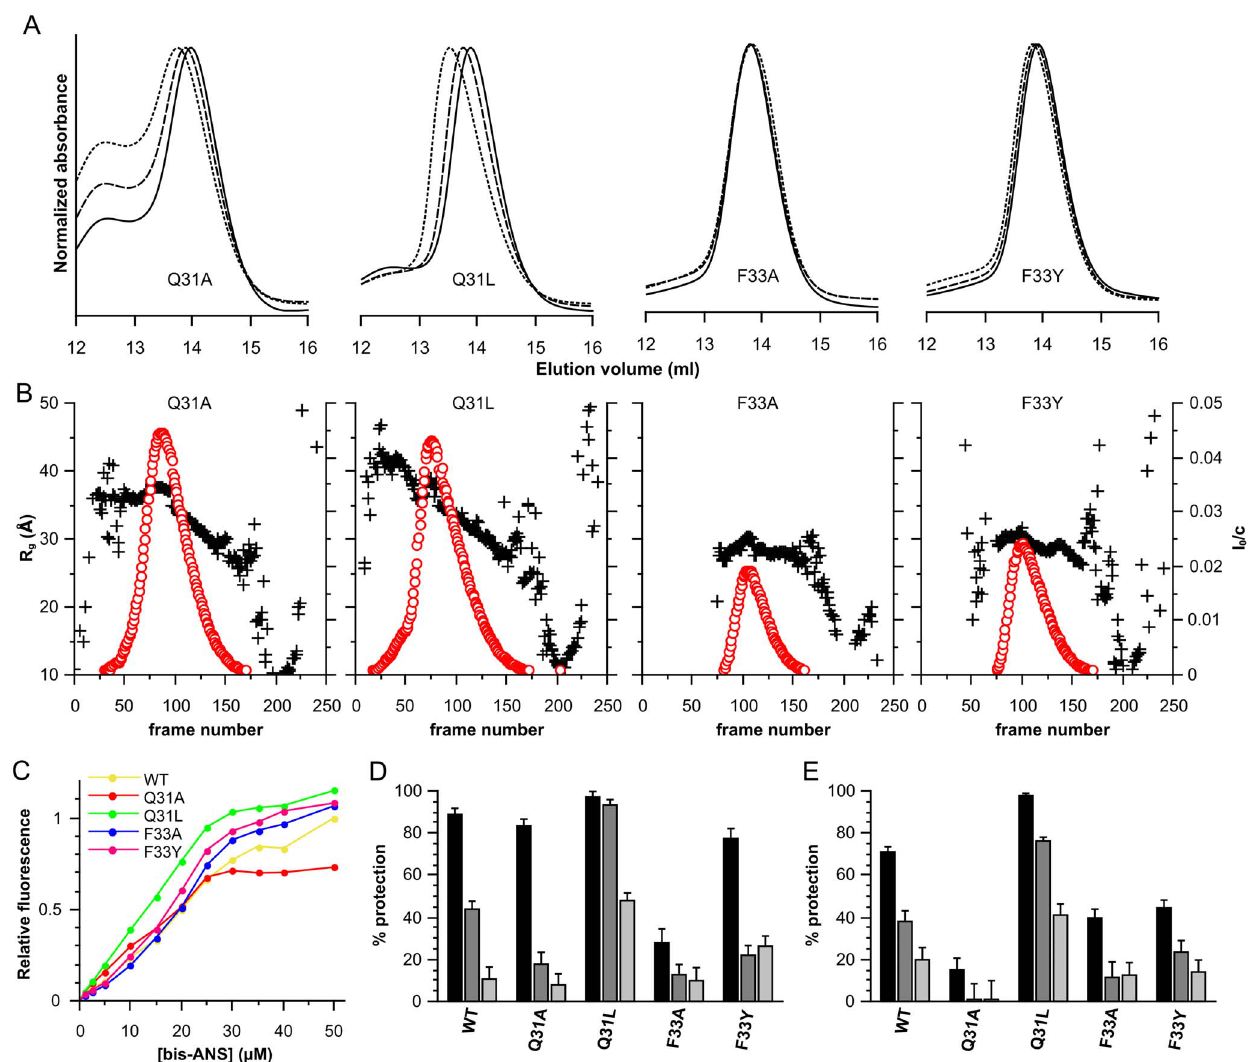
Figure 8. Characterization of the HSPB6 point mutations. (A) Size-exclusion chromatography profiles. 100 m l of protein was loaded onto a Superdex 200 10/300 GL column at different concentrations. 2.5 mg/ml is depicted as a full line, 5 mg/ml as a dashed line and 10 mg/ml as a dotted line. The absorbance was normalized to the maximum absorbance for each curve. (B) SAXS analysis of the HSPB6 mutants. For each construct, 250 frames were collected during elution from a Shodex KW-404F column. The radius of gyration (R g ) and forward scattering (I 0 ) were calculated at each measured point using buffer subtracted scattering curves that had been averaged by a ten-frame moving average algorithm to improve the signal- to-noise. The forward scattering values are normalized by dividing the values by the concentration of the sample at the peak maximum. The R g is plotted as a black cross for each construct and scaled on the left axis, the I 0 is shown as a red circle and scaled on the right axis. (C) Bis-ANS titration curves, 2.5 m M protein was mixed with increasing concentrations of bis-ANS and fluorescence intensities were measured at 490 nm using and excitation wavelength of 390 nm. Wild type B6 is shown in yellow, Q31A in red, Q31L in green, F33A in blue and F33Y in pink. (D) Chaperone-like activity of wild-type HSPB6 and its mutants against aggregating insulin, the monomer mass molar ratios tested were 1:0.2 (black), 1:0.1 (dark gray) and 1:0.05 (light gray). (E) Chaperone-like activity of wild type B6 and its mutants against aggregating yADH. The ratios used are 1:2 (black), 1:1 (dark gray) and 1:0.5 (light